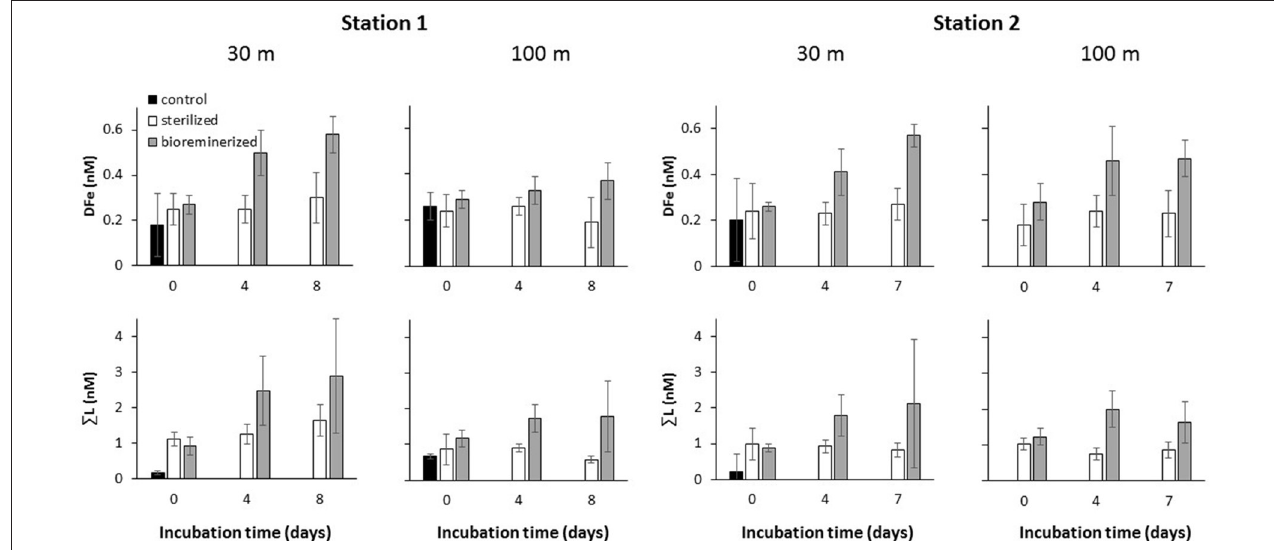
FIGURE 2 | Release of DFe and production of 6 L. from re-suspended marine particles > 5.0 µ m during dark incubation at ambient seawater temperature of specified depths (i.e., 30 and 100m) at station 1 and 2. Control filtered seawater and microwave sterilized particle suspensions were treated in the same